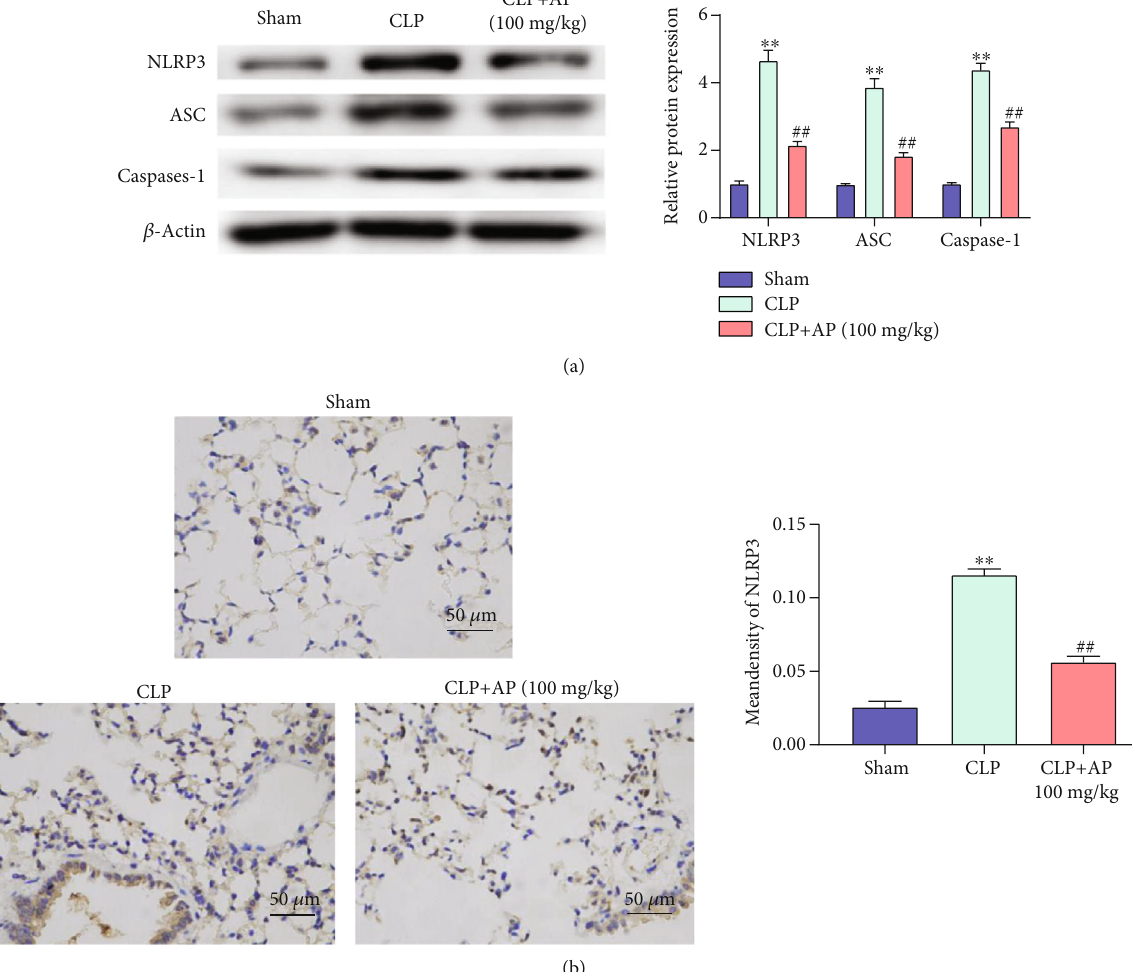
Figure 6: AP inhibited the activation of the NLRP3 in fl ammasome in sepsis-induced ALI mice. (a) The expressions of NLRP3, ASC, and caspase-1 were measured by western blot. (b) The expression of NLRP3 was detected by immunohistochemistry. ∗∗ P < 0 : 01 , vs. Sham group; ## P < 0 : 01 , vs. CLP